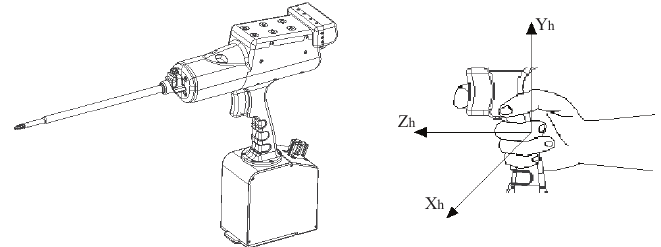
Figure 1. The biodynamic coordinate system of